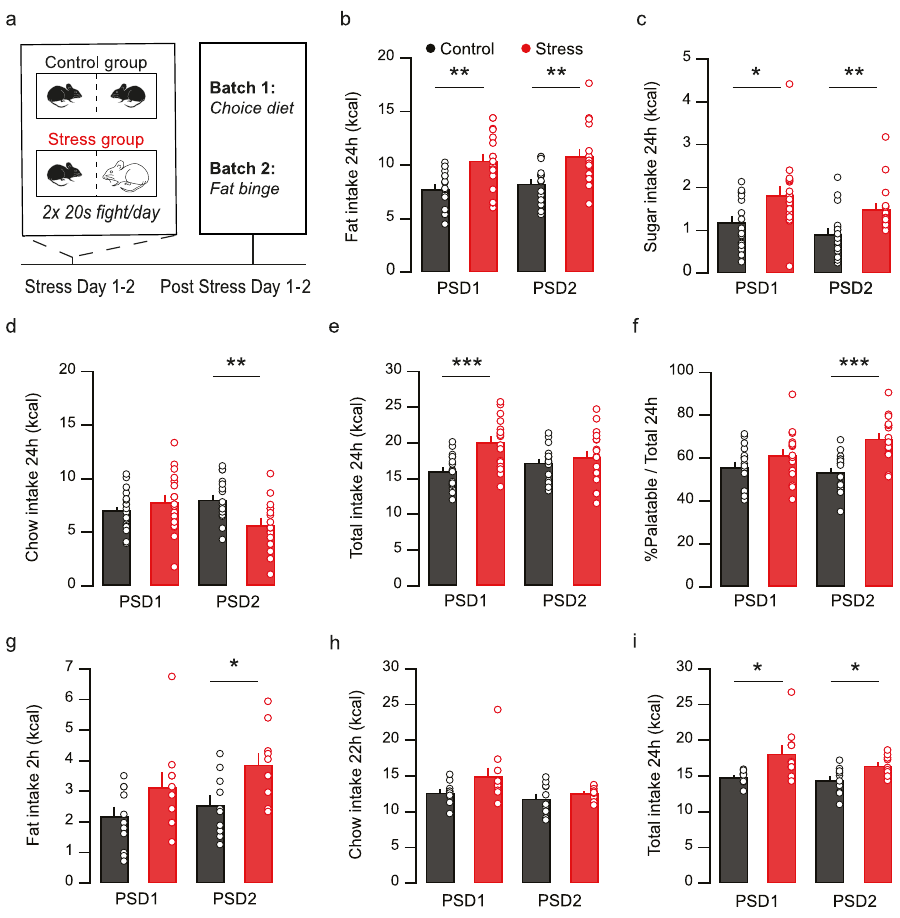
Fig.1|Socialstressincreasespalatablefoodintake.a Timelineandschematicfor social stress protocol followed by ad libitum High Fat High Sugar (HFHS) diet